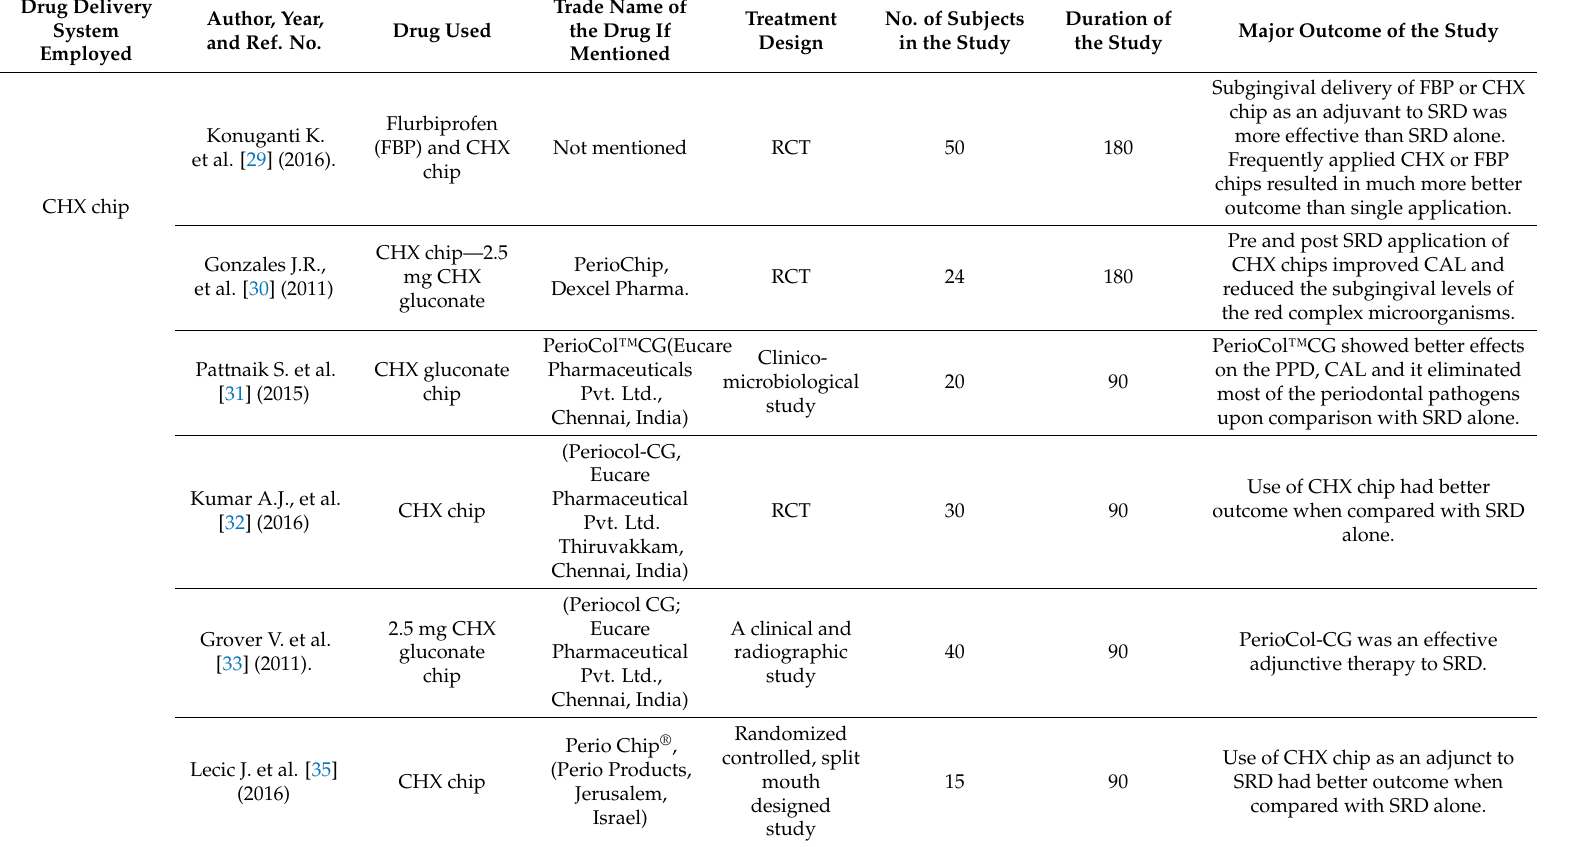
Table 2. 10-year detailed summary of locally delivered controlled release antimicrobial matrix delivery systems. Drug Delivery